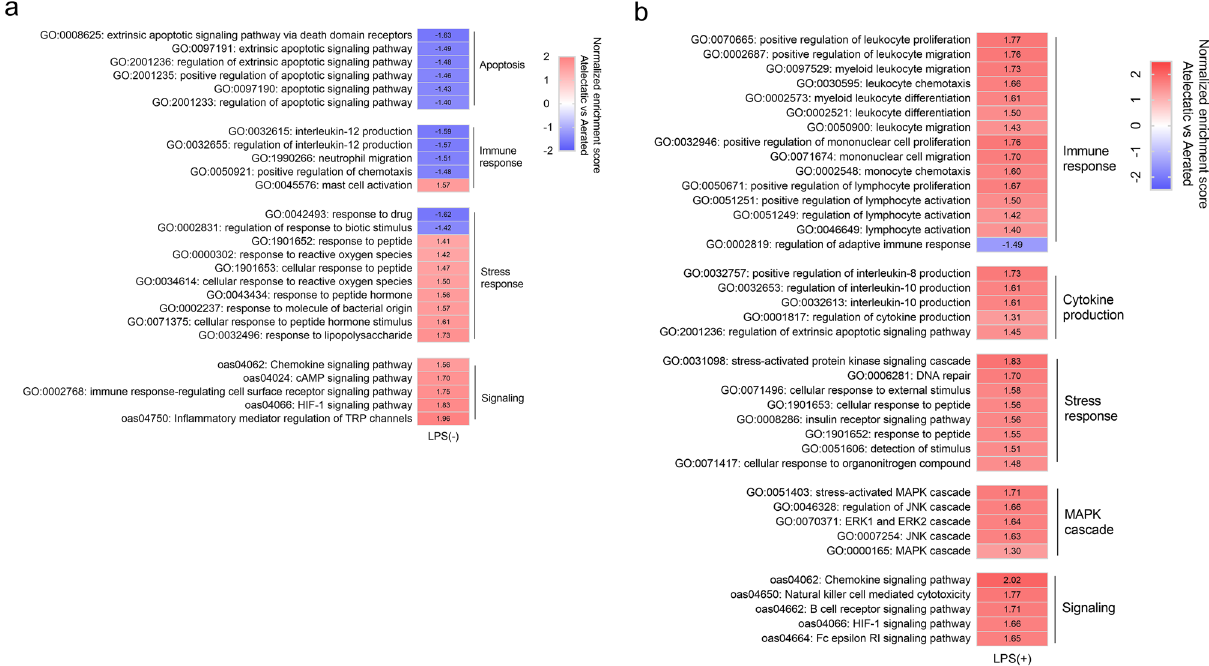
atelectasis in LPS(+) condition. Red represents a positive normalized enrichment score. Blue represents a negative normalized enrichment score. LPS lipopolysaccharide, cAMP cyclic adenosine monophosphate,